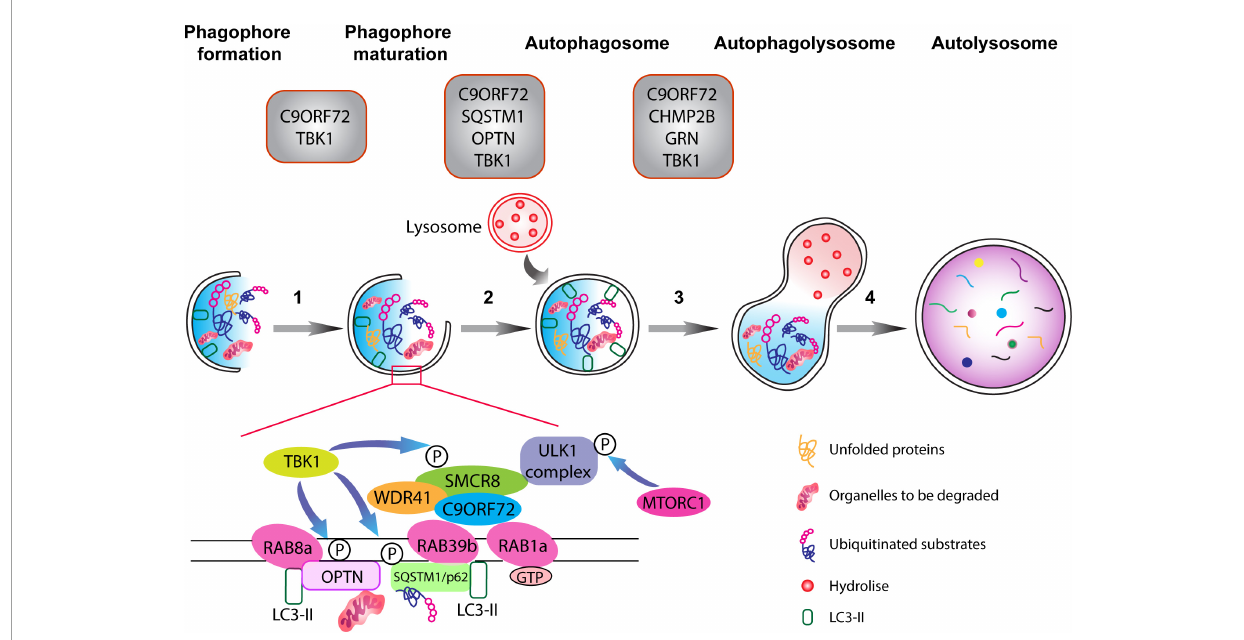
FIGURE1 The autophagy pathway. Schematic representation of different phases of the autophagy pathway from phagophore formation to the degradation of dysfunctional organelles and ubiquitinated proteins (the autophagic cargo) within autolysosomes. Top: gray boxes depict the various proteins associated with ALS-FTD that normally function at defined stages of the autophagolysosome formation. Autophagy is composed of multiple steps (1) phagophore formation, where double membrane phagophore forms around damaged molecules, unfolded proteins, and compromised organelles, (2) phagophore maturation and elongation, (3) the formation of the mature phagophore carrying the autophagic cargo, (4) the fusion of the phagosome with lysosome containing hydrolytic enzymes, which degrade the content of the autophagic cargo. The C9ORF72-WDR1-SMCR8 complex regulates autophagy at the initiation and progression phases (steps 1–3). RAB1a GTPase can recruit the C9ORF72 complex to engage the ULK1 complex during the initial phase of the autophagy pathway. Importantly, RAB8a and RAB39b, respectively, bind to OPTN and SQSTM1/p62,